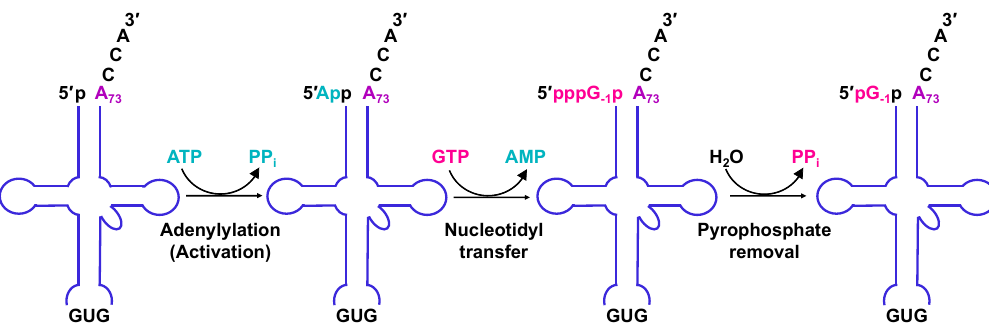
Figure 4. Eukaryotic Thg1 catalyzes a three-step reaction. ScThg1 adds G -1 in three consecutive steps.